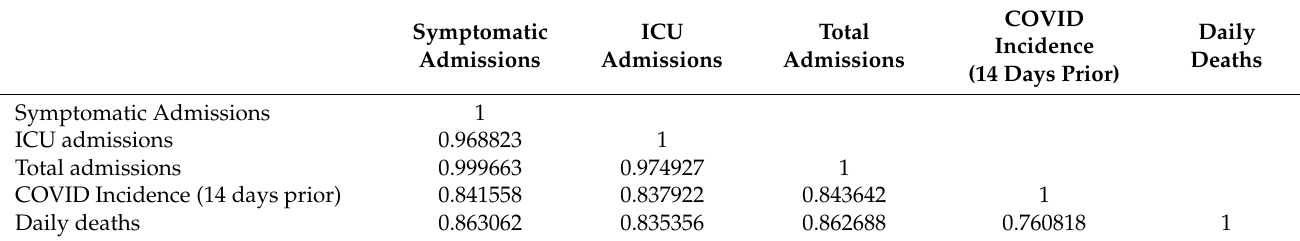
Table 1. Collinearity of epidemiological variables.